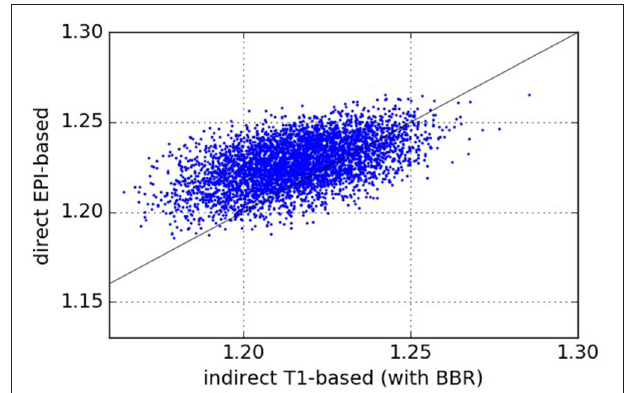
FIGURE 3 | Normalized Mutual Information—NMI (higher values are better). Each point ( x , y ) on the plots such that x is the NMI of a given pair of subjects registered using the pipeline on the abscissa and y is the NMI of the same pair of subjects registered using the pipeline on the ordinate. From the one-sided We see that our proposed direct EPI-based pipeline significantly outperforms the classical indirect T1-based pipeline.